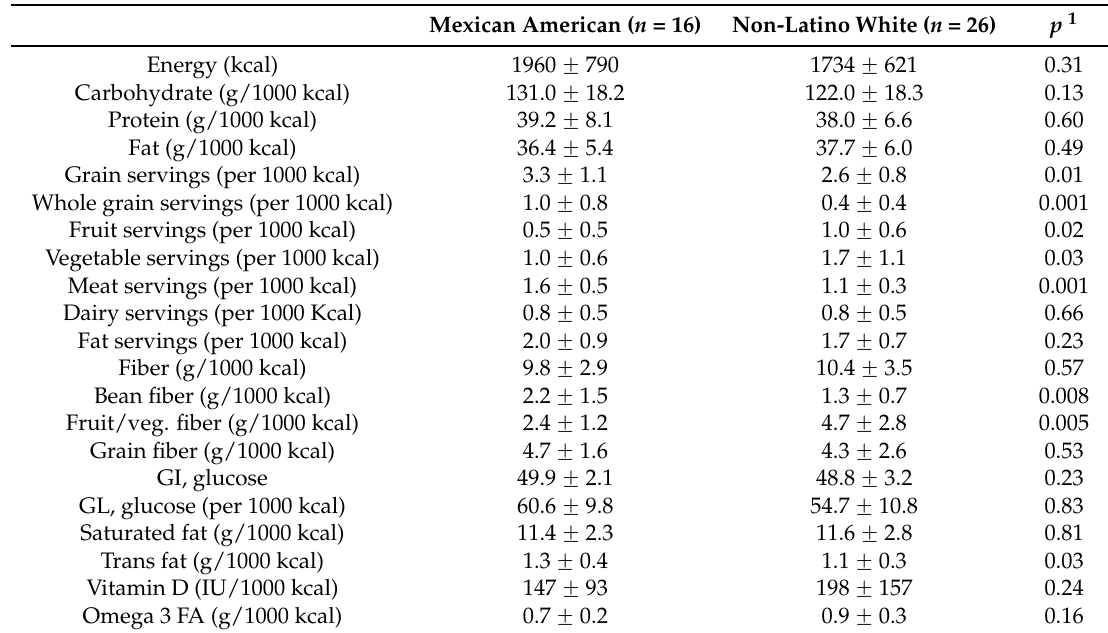
Table 3. Daily dietary measures by ethnicity and